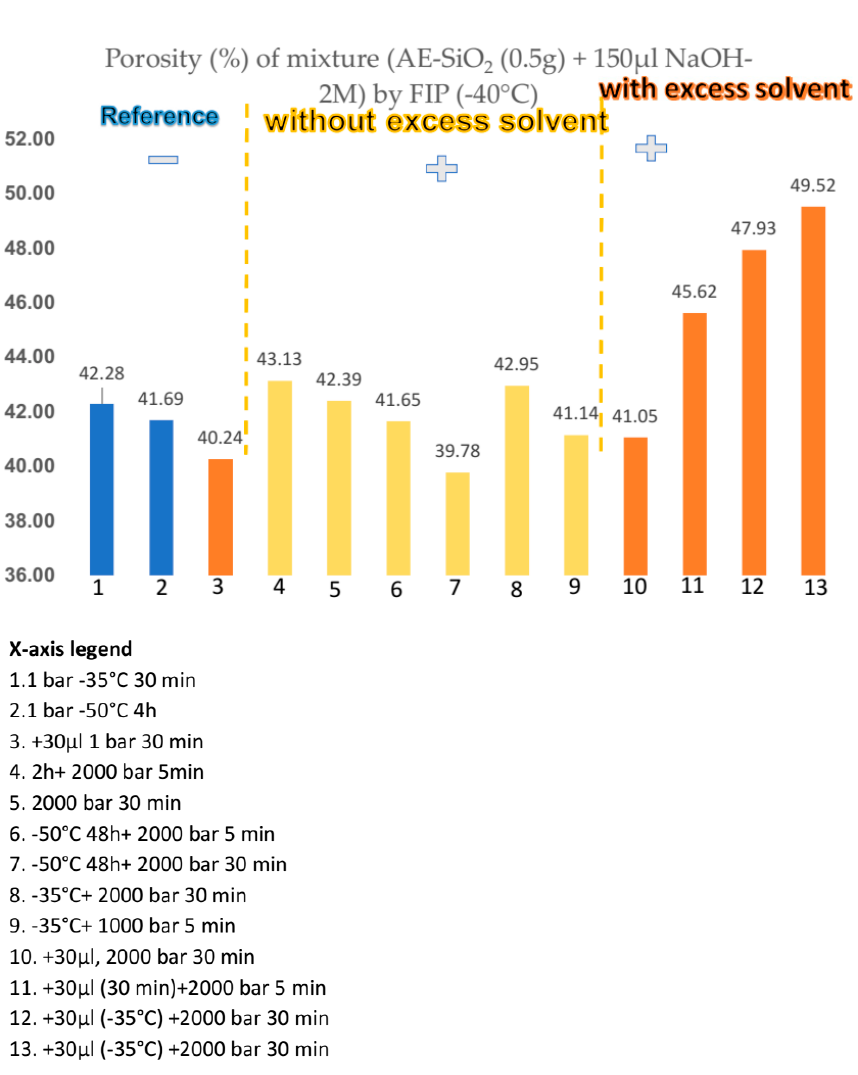
Figure 5. Porosity as a function of various parameter of FIP process.